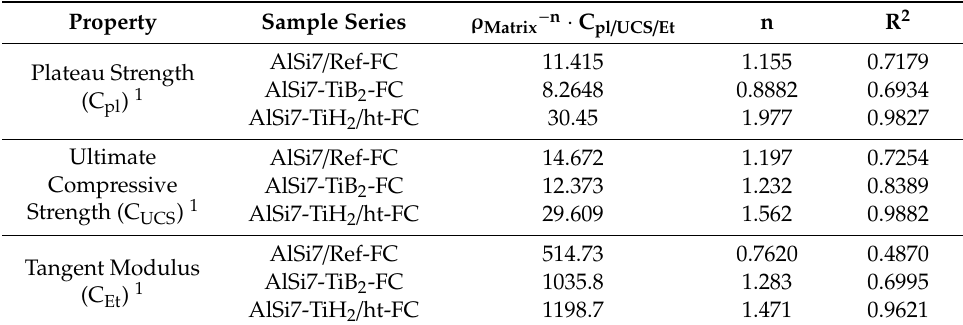
Table 5. Compression test results, comparison of fit curve parameters for density dependence of plateau and ultimate strength as well as tangent modulus for di ff erent sample series (standard series with TiH 2 as received and thermally treated, TiB 2 grain refined with TiH 2 as received—all series produced using forced convection cooling with